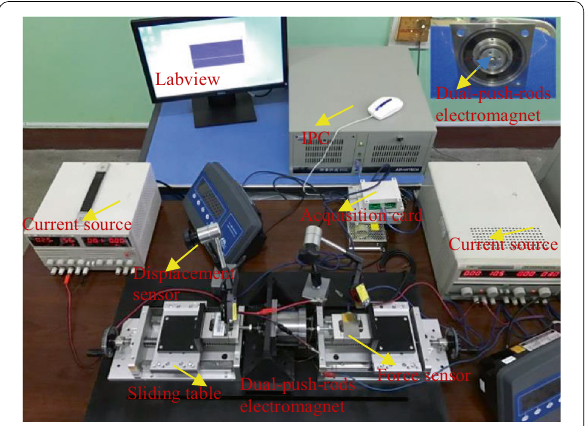
Figure 9 Electromagnetic force–displacement curves of outer